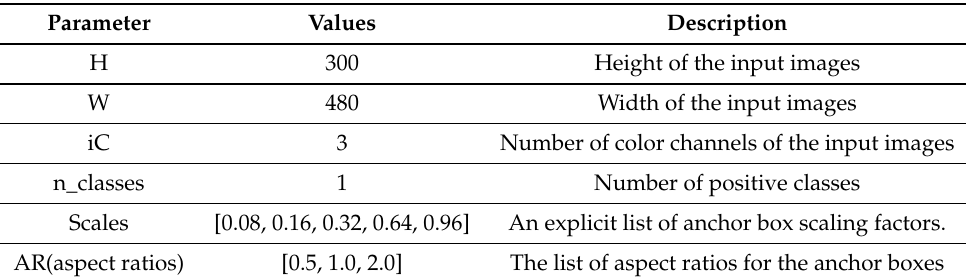
Table 1. Primary configurations for